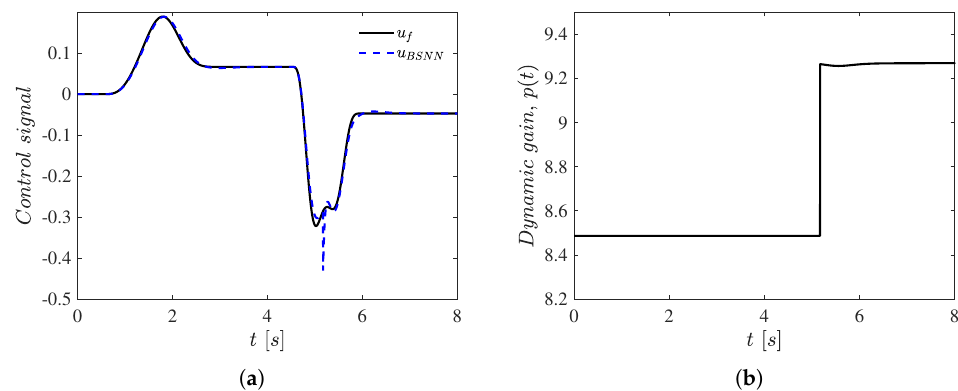
Figure 5. ( a ) Control signal u ; ( b ) evolution of the parameter p used in the control scheme.